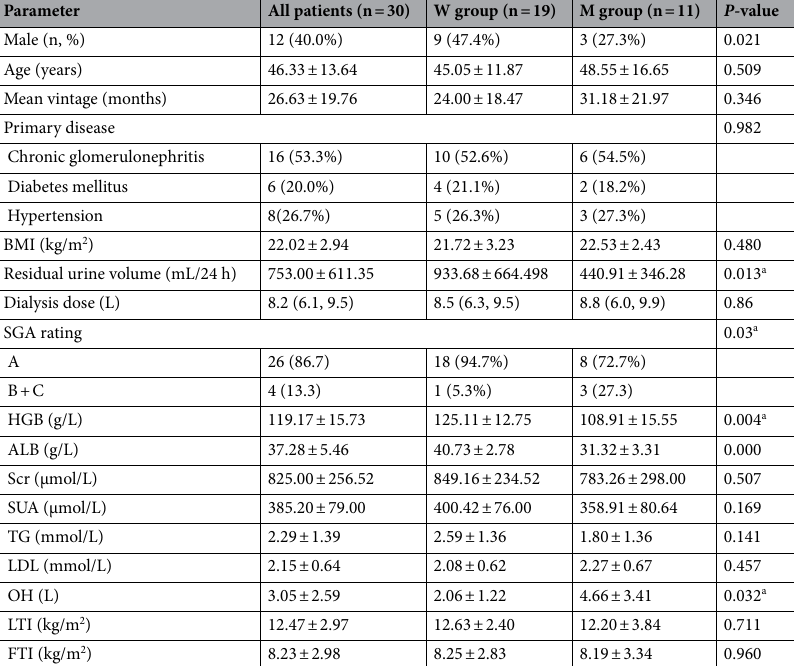
Table 1. Clinical characteristics of the continuous ambulatory peritoneal dialysis (CAPD) patients. W group Well-nourished group, M group Malnourished group , BMI body mass index, SGA subjective global assessment of malnutrition, HGB hemoglobin, ALB serum albumin, Scr serum creatinine, SUA serum uric acid, TG triglycerides, LDL low-density lipoproteins, OH overhydration, LTI lean tissue index, FTI fat tissue index. a P < 0.05 indicates statistically significant differences. Intergroup comparisons of numerical and categorical data were performed using the independent samples t-test and Fisher’s exact test. Data are expressed as χ ±